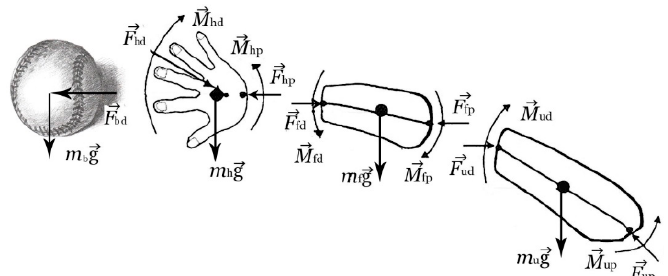
Figure 3. Free body diagram analysis of ball, hand, forearm and upper arm ( F p is the proximal end joint force; F d is the distal end joint force; mg is the gravity force; M p is the proximal end joint moment; M d is the distal end joint moment; u is upper arm; f is forearm; h is hand).